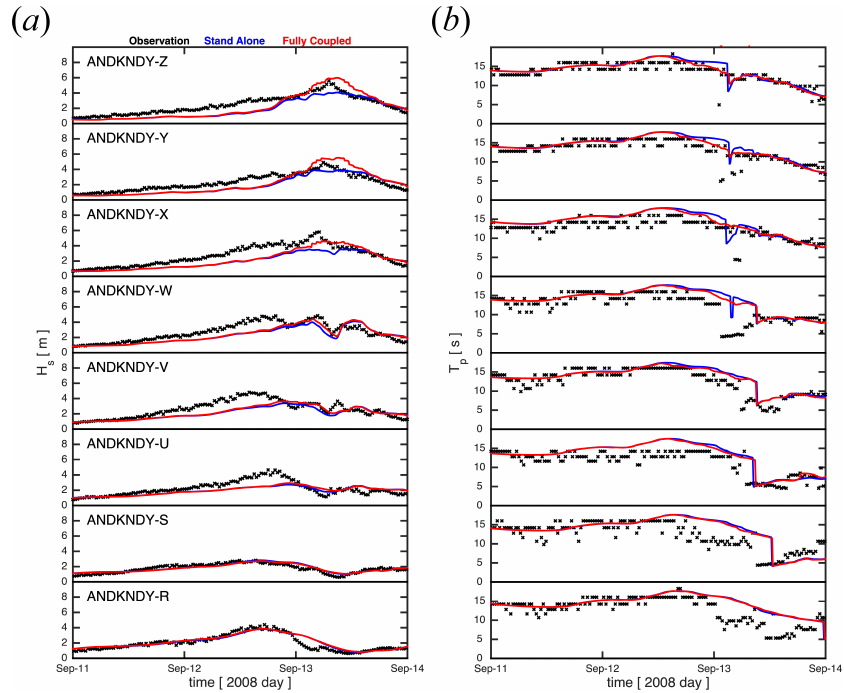
Figure 18. Model validation at quick deployed gauges, forced by HWRF atmospheric model, extracted from Stand alone WW3 simulations (blue), Fully coupled wave-surge simulation (red) versus observation (black): ( a ) Significant wave height ( H s ); and ( b ) peak period ( T p ). All model configurations and results are pre-decisional and for official use